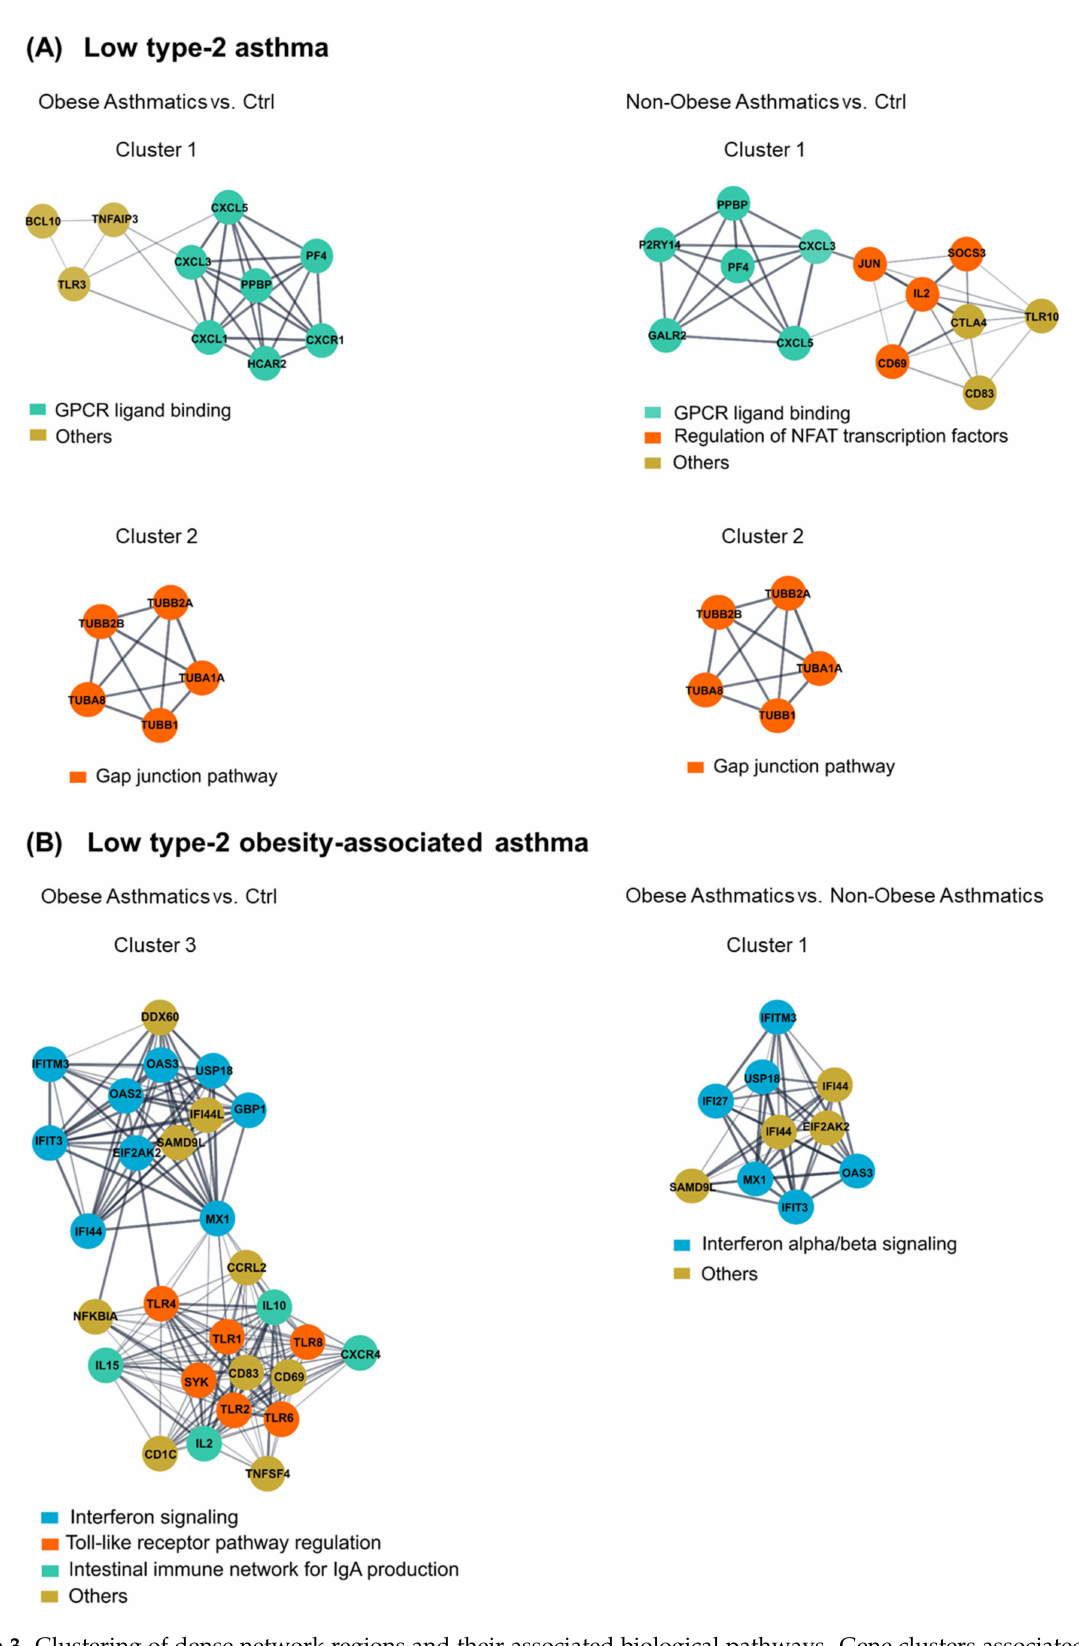
Figure 3. Clustering of dense network regions and their associated biological pathways. Gene clusters associated with shared pathways between (( A ), left) obese asthmatics vs. Ctrl (healthy controls) and (( A ), right) non-obese asthmatics vs. Ctrl, as well as between (( B ), left) obese asthmatics vs. Ctrl and (( B ), right) obese asthmatics vs. non-obese